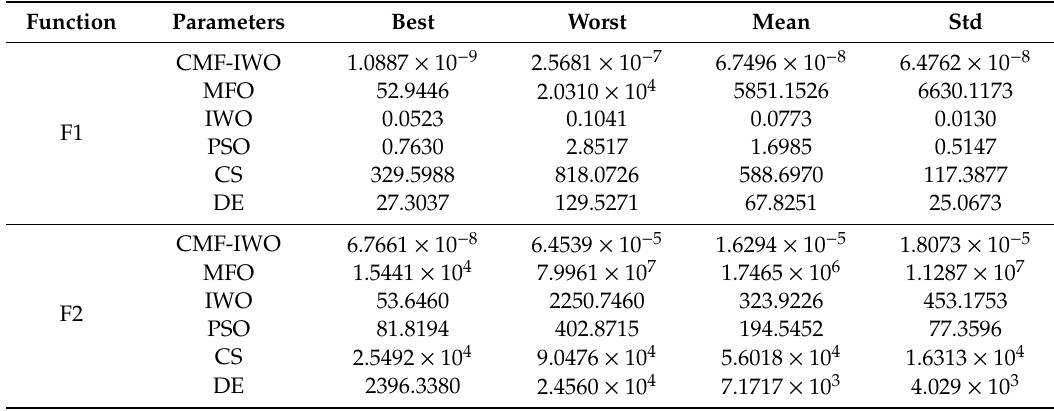
Table 3. Statistical results of five benchmark